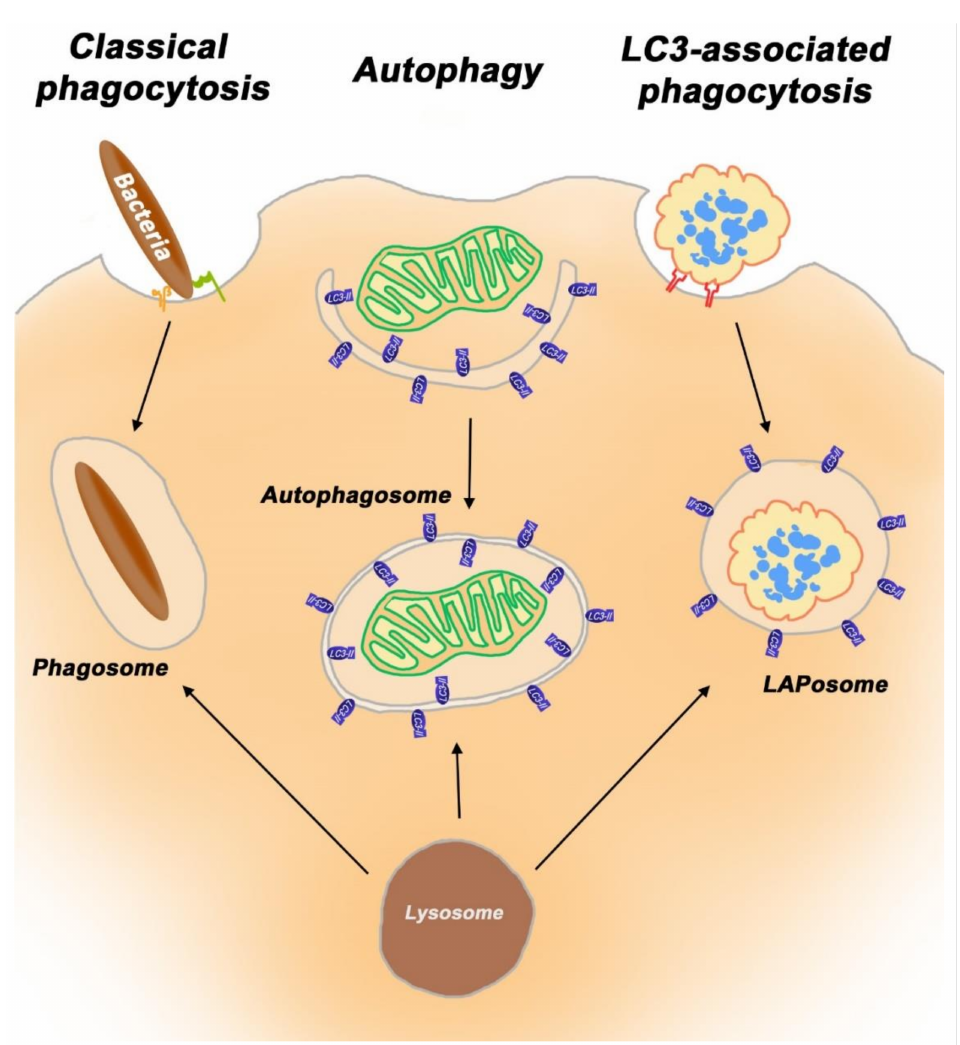
Figure 2. Phagocytosis, autophagy and LAP are functionally and mechanistically distinct degradative